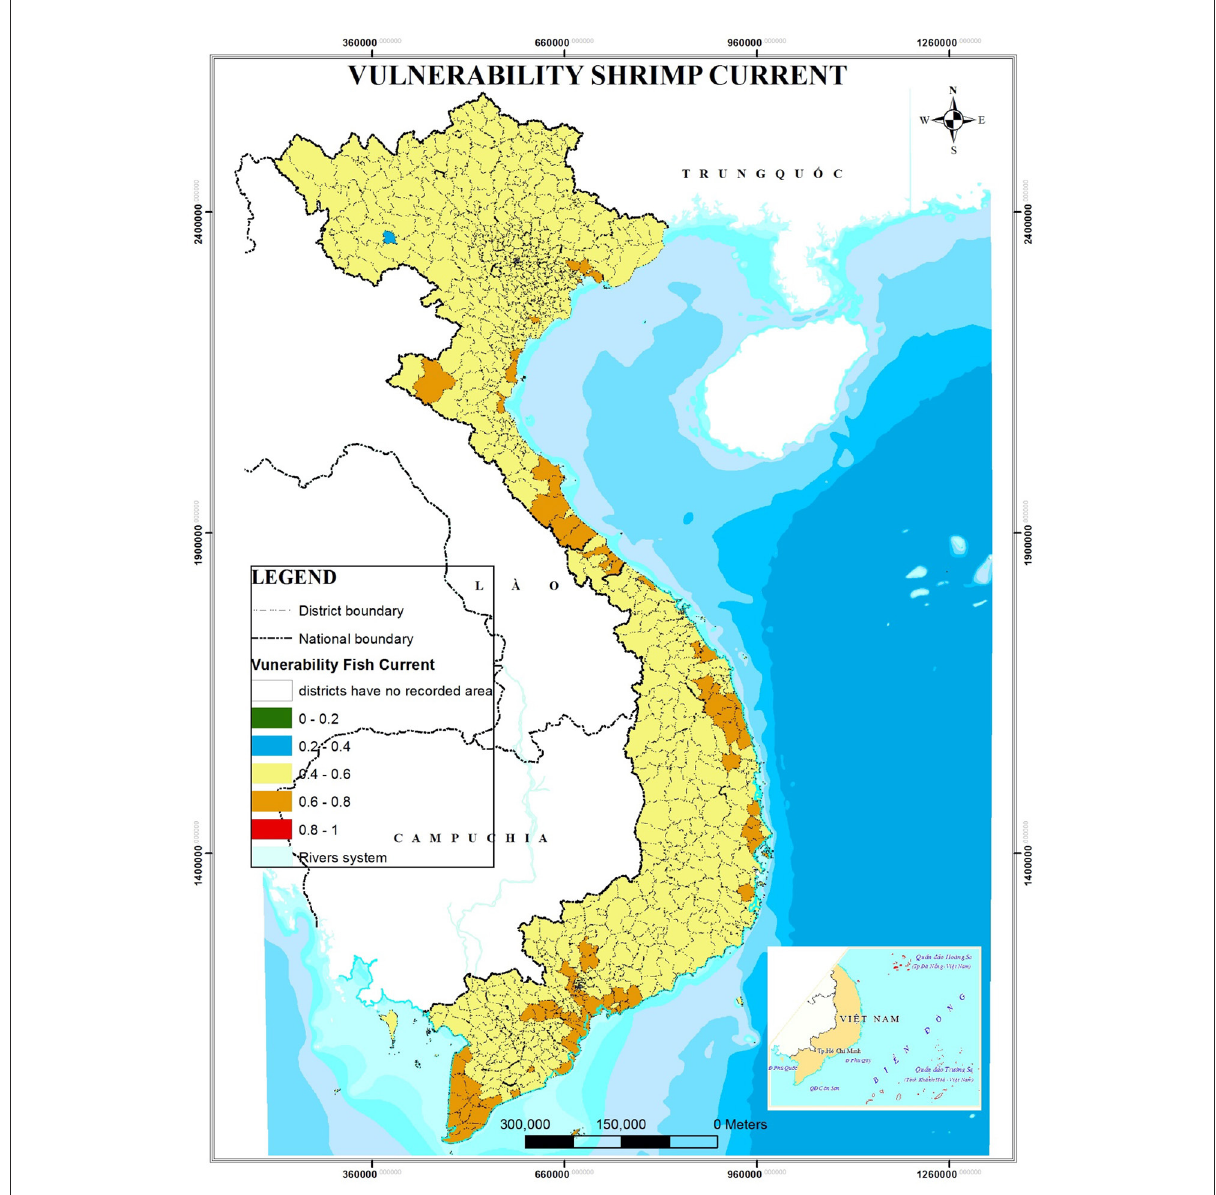
FIGURE5 Vulnerable level of shrimp farming to climate change. Source: Cao et al.